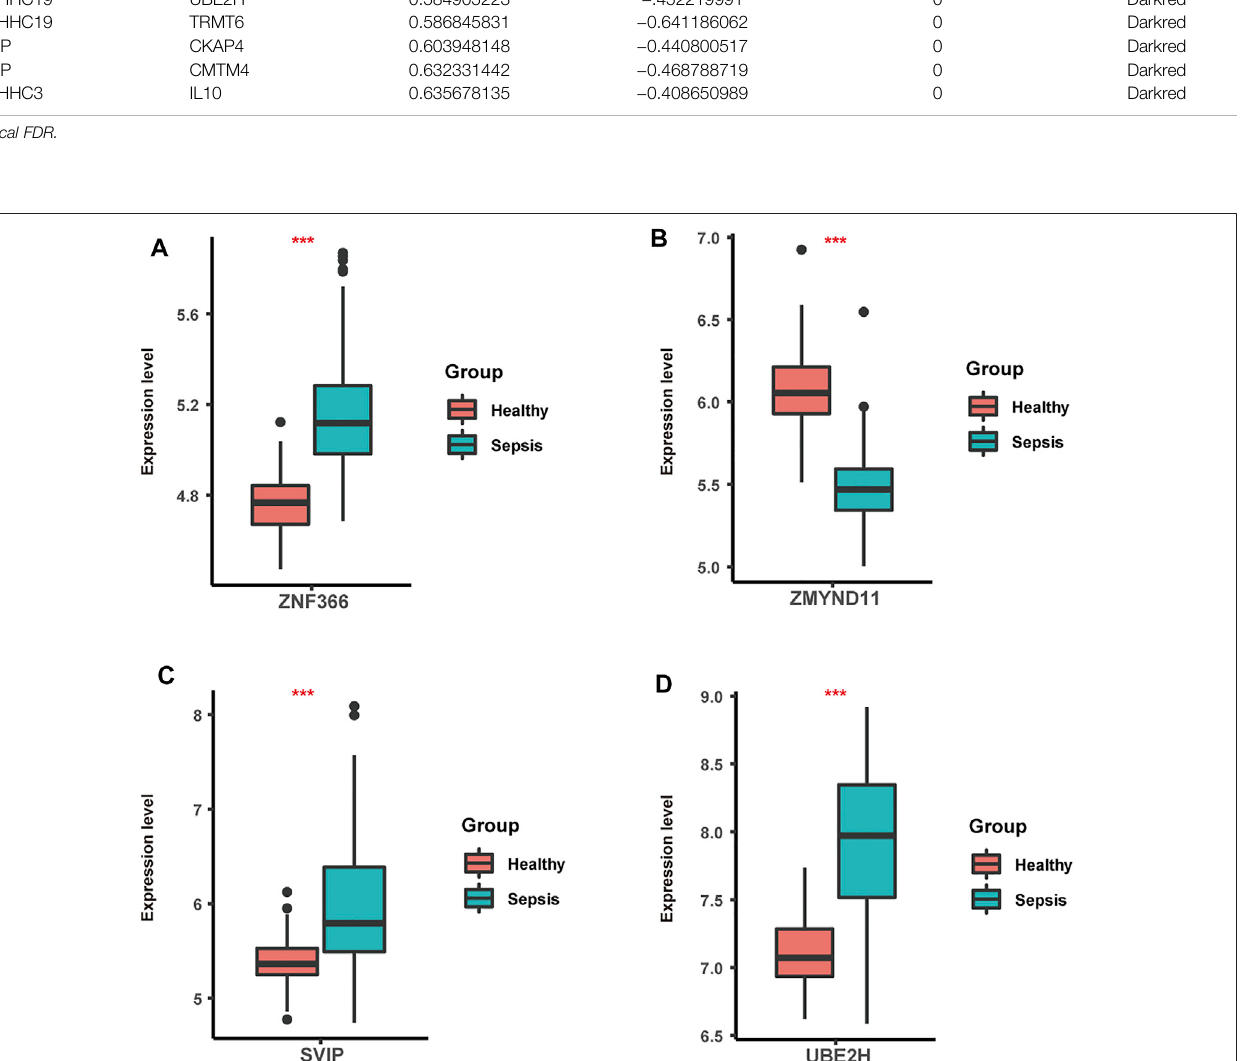
Frontiers in Genetics |